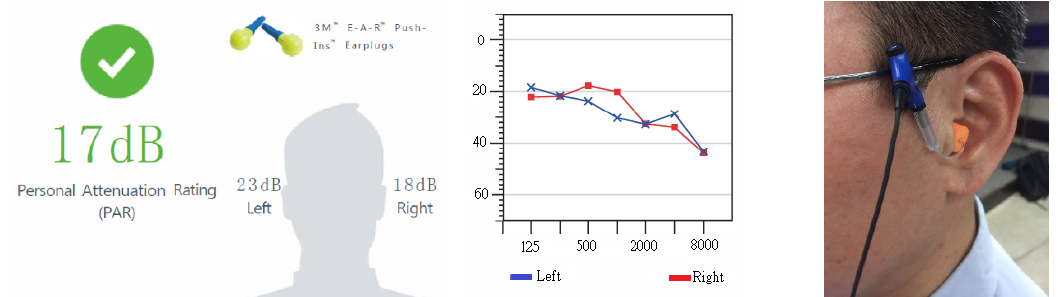
Figure 5. An example where the test result of the PAR value was “pass” after additional instructions and a different type of HPD were provided, followed by a re-test of the adaptability with the new HPD.